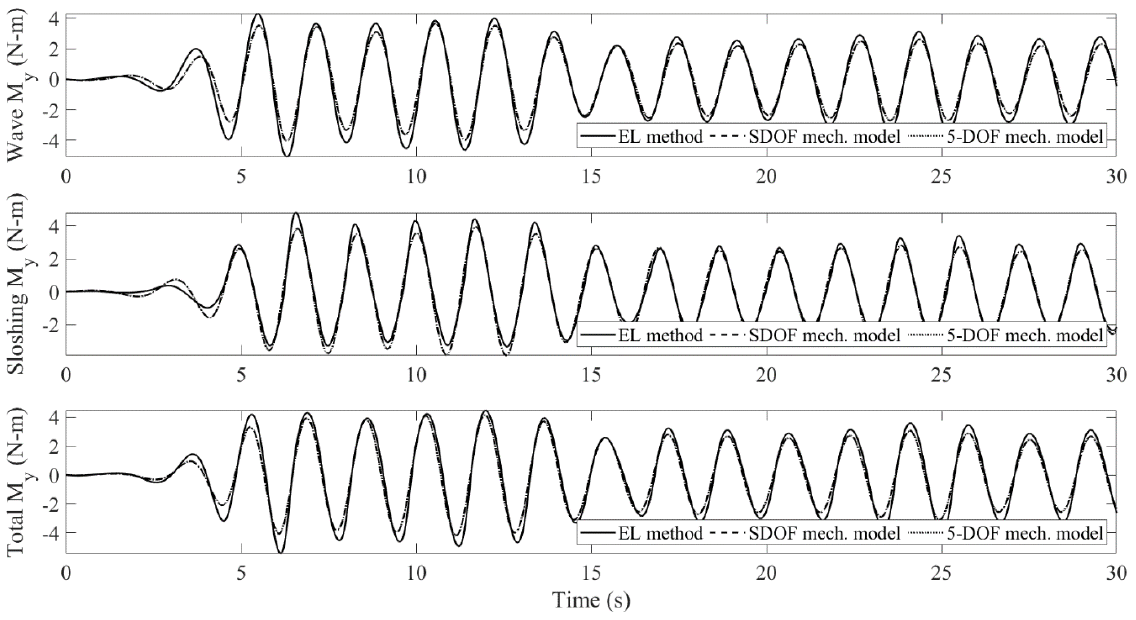
Figure 18. The pitch motion responses of the floating body, configured with a water tank installed with porous media, undergoing small wave excitation.